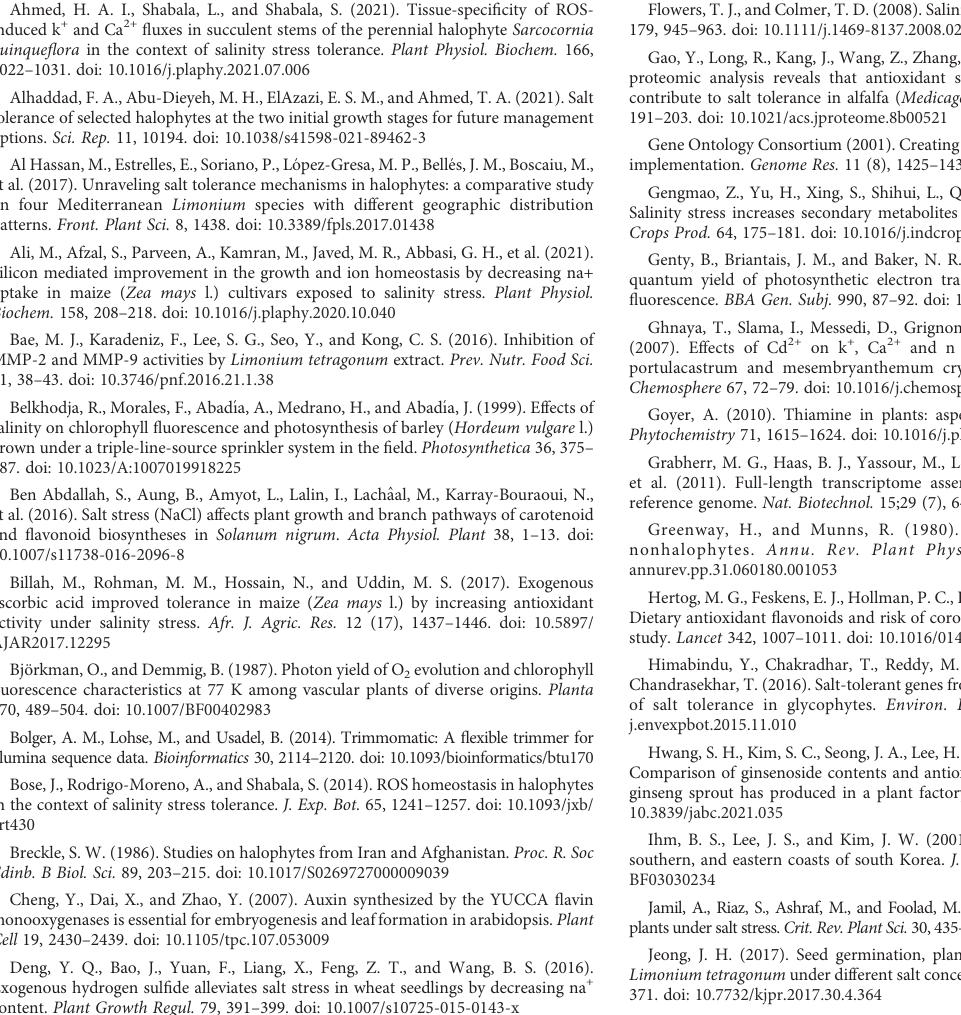
SUPPLEMENTARY FIGURE 1 The photon fl ux density for the wavelength of the LED.